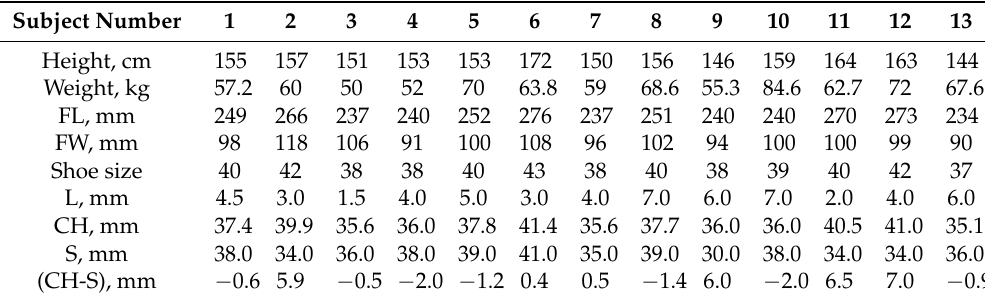
Table 1. A detailed description of each subject.